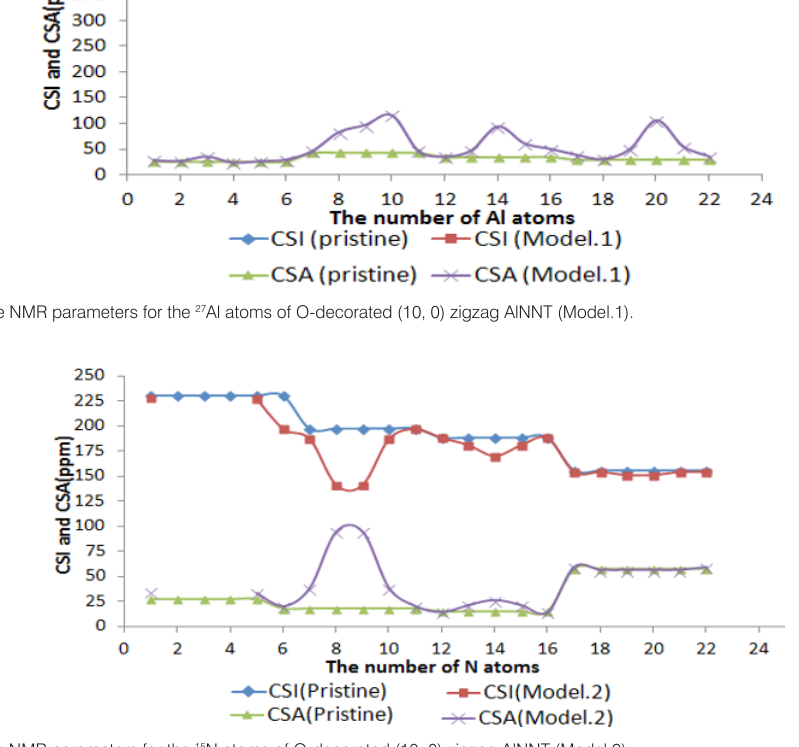
Figure 9. The NMR parameters for the 15 N atoms of O-decorated (10, 0) zigzag AlNNT